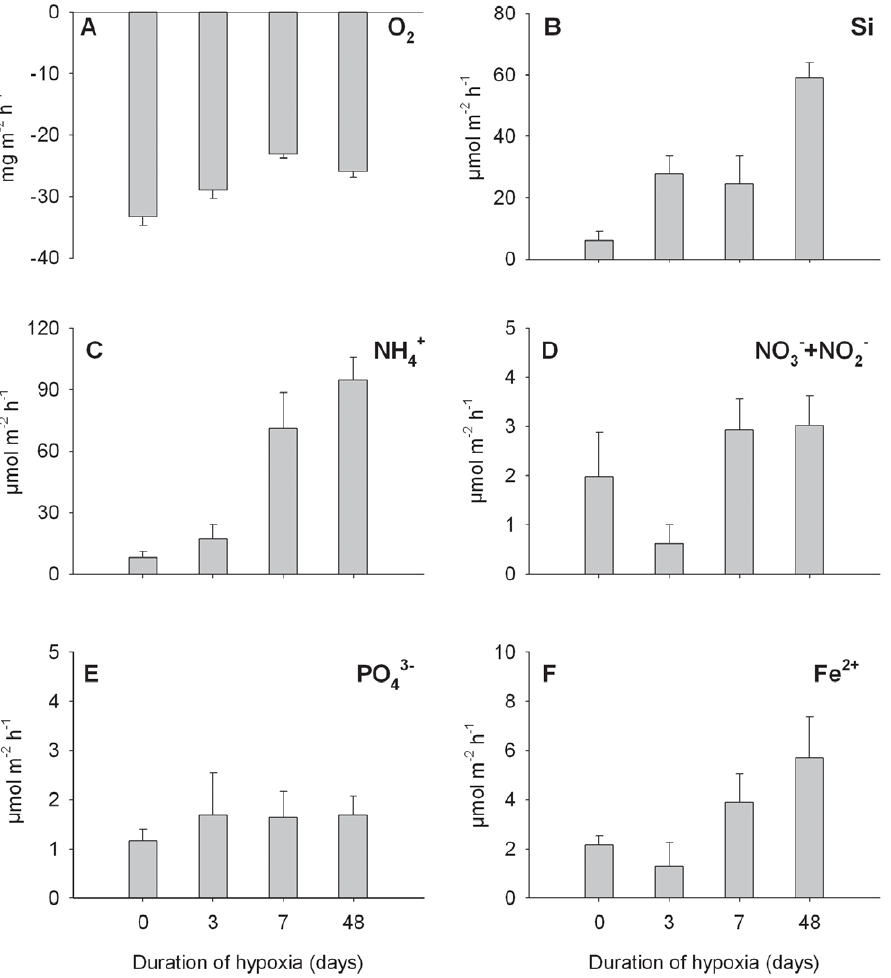
Figure 3. Changes in sediment nutrient fluxes due to increasing duration of hypoxia. The graphs show the average flux ( 6 SE, N=4) of (A) O